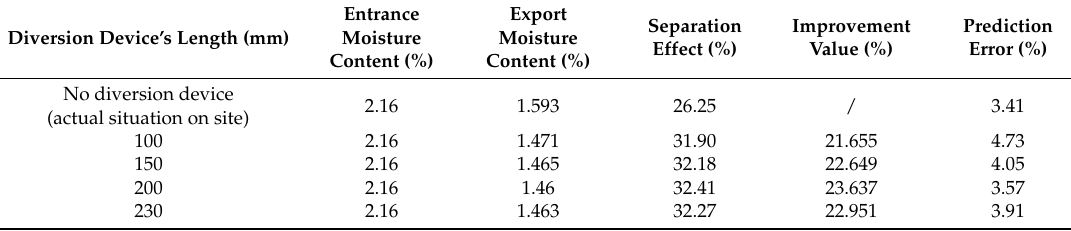
Table 4. Comparisons of optimized results with field data.